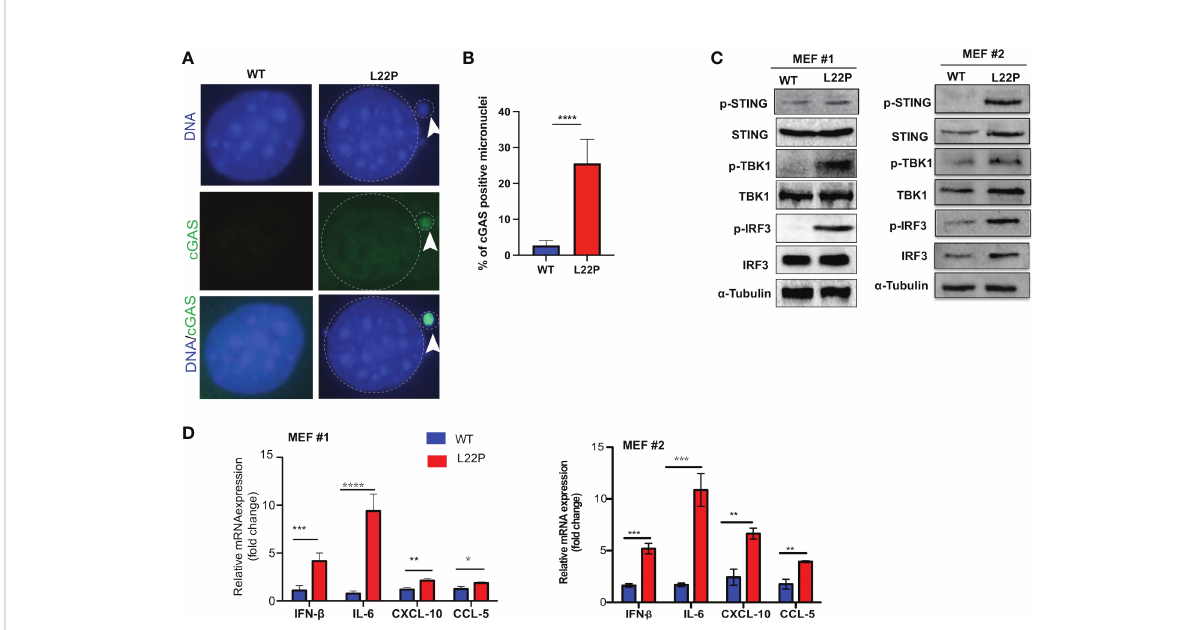
FIGURE 3 POLB defective cells exhibit cytosolic mediated cGAS-STING activation. (A) Representative image localization of cGAS at micronuclei; (B) Quanti fi cation of positive cGAS localization at micronuclei; (C) STING/TBK1/IRF-3 signaling pathway activation detected with Western blot of protein extract from WT and L22P cells. Anti-STING/anti-Phospho-STING (Ser366); IRF3/p-IRF3 (ser385); TBK1/P-TBK-1 (Ser172) antibodies were used to detect the activation of cGAS/STING dependent pathway. Two MEF cell lines (labeled as MEF #1 and MEF #2) were used to generate the data; (D) Fold change in mRNA expression of type I interferon cytokines measured using RT-qPCR in dRP lyase de fi cient (L22P) versus pro fi cient cells (WT). Data were analyzed using a paired t-test in GraphPad Prism; P*<0.05, **P<0.01, ***P<0.001,